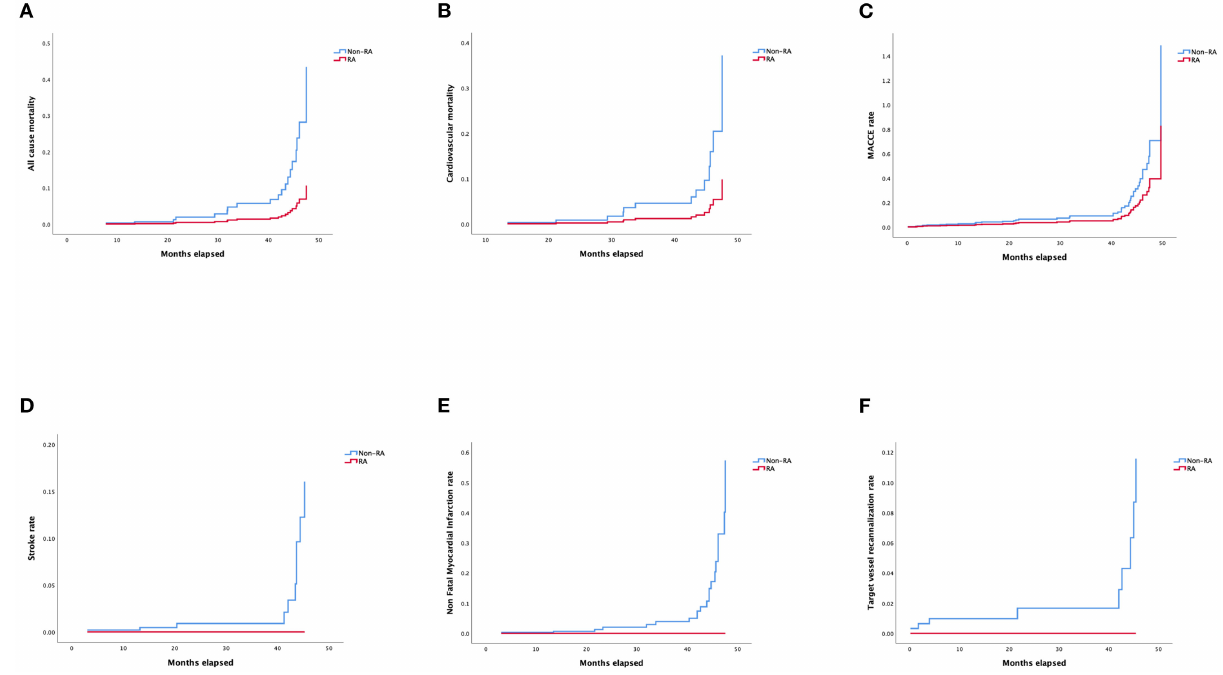
FIGURE 3 | (A) Adjusted Kaplan–Meier curves of all-cause mortality according to Cox regression model. (B) Adjusted Kaplan–Meier curves of cardiovascular mortality according to Cox regression model. (C) Adjusted Kaplan–Meier curves of MACCE rate according to Cox regression model. (D) Adjusted Kaplan–Meier curves of stroke rate according to Cox regression model. (E) Adjusted Kaplan–Meier curves of non-fatal myocardial infarction rate according to Cox regression model. (F) Kaplan–Meier curves of target vessel recanalization rate according to Cox regression